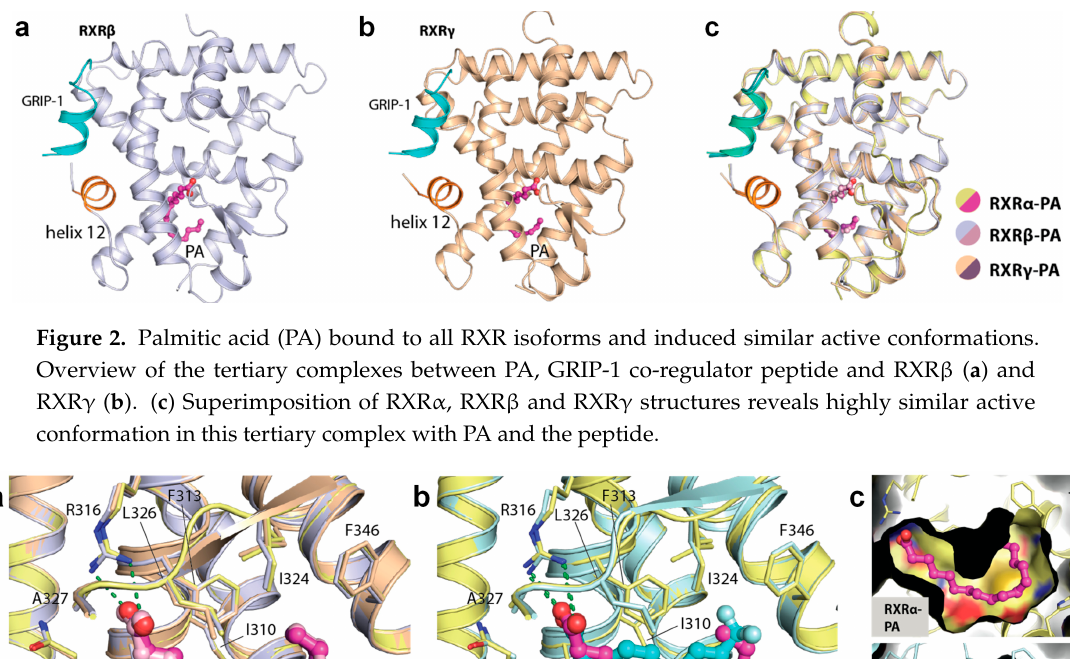
Figure 2. Palmitic acid (PA) bound to all RXR isoforms and induced similar active conformations. Overview of the tertiary complexes between PA, GRIP-1 co-regulator peptide and RXR β ( a ) and RXR γ ( b ). ( c ) Superimposition of RXR α , RXR β and RXR γ structures reveals highly similar active conformation in this tertiary complex with PA and the peptide.